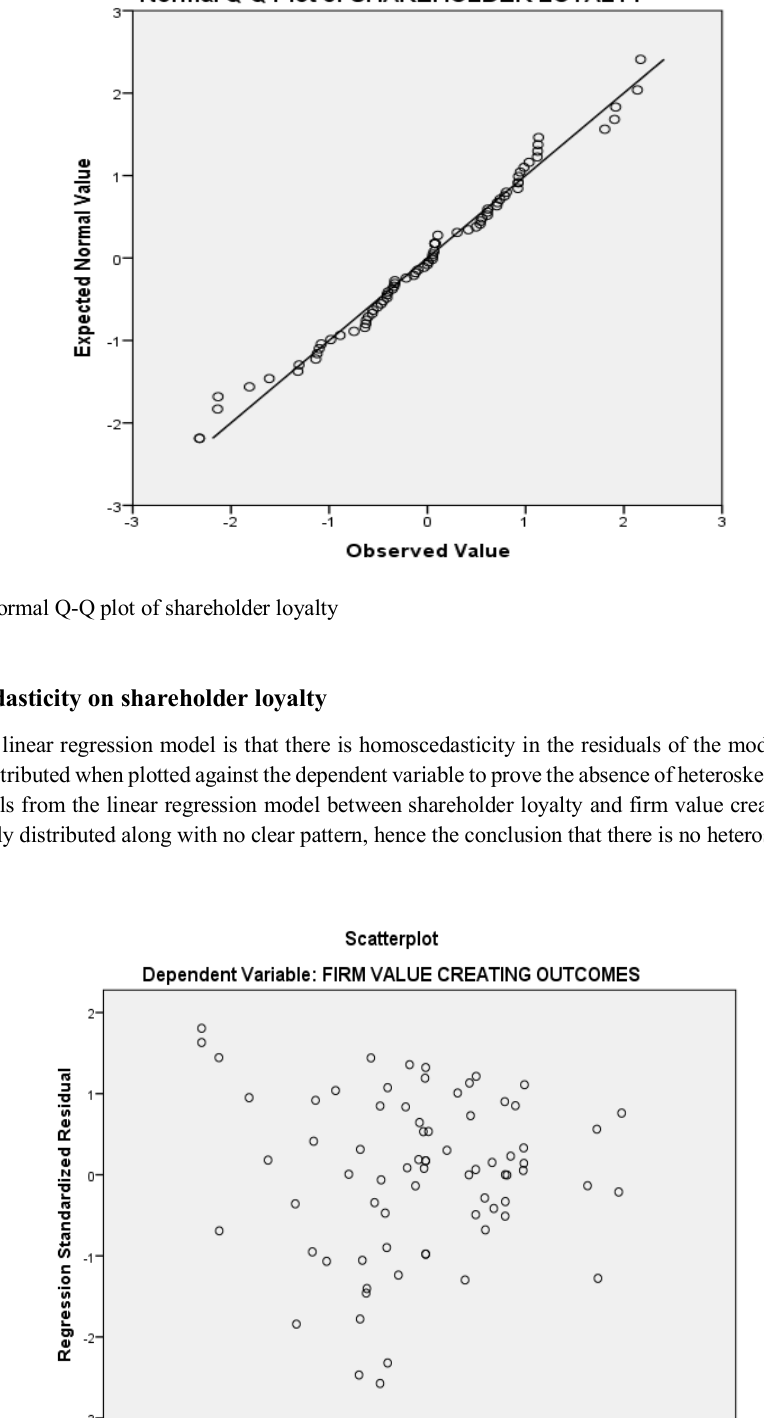
Figure 2: Test for heteroskedasticity on shareholder loyalty Regression